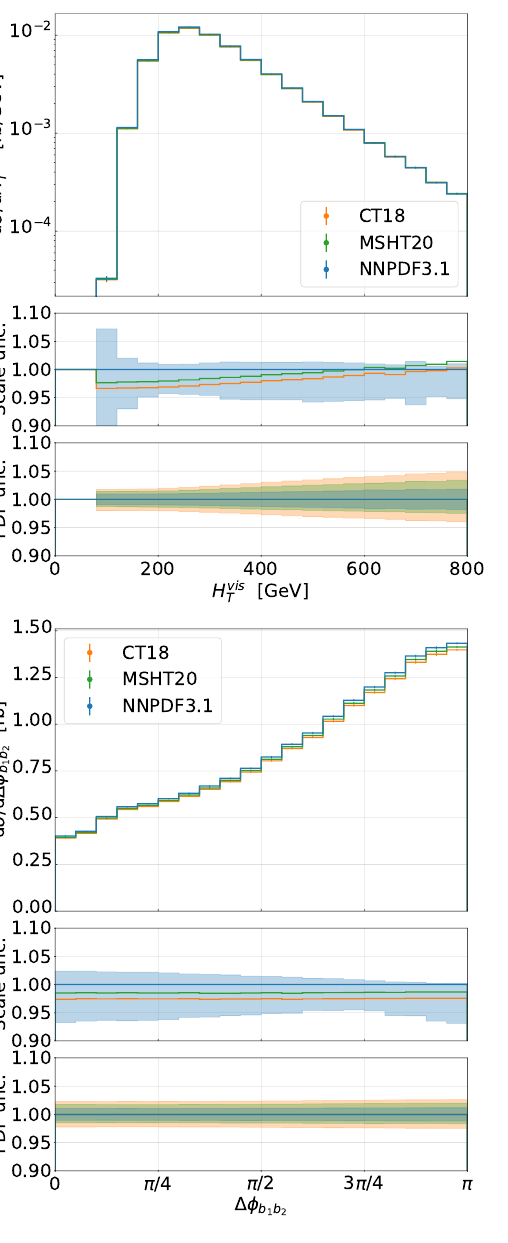
, M b , ∆ φ b and T √ 1 b 2 1 b 2 s = 13 TeV. The upper panels